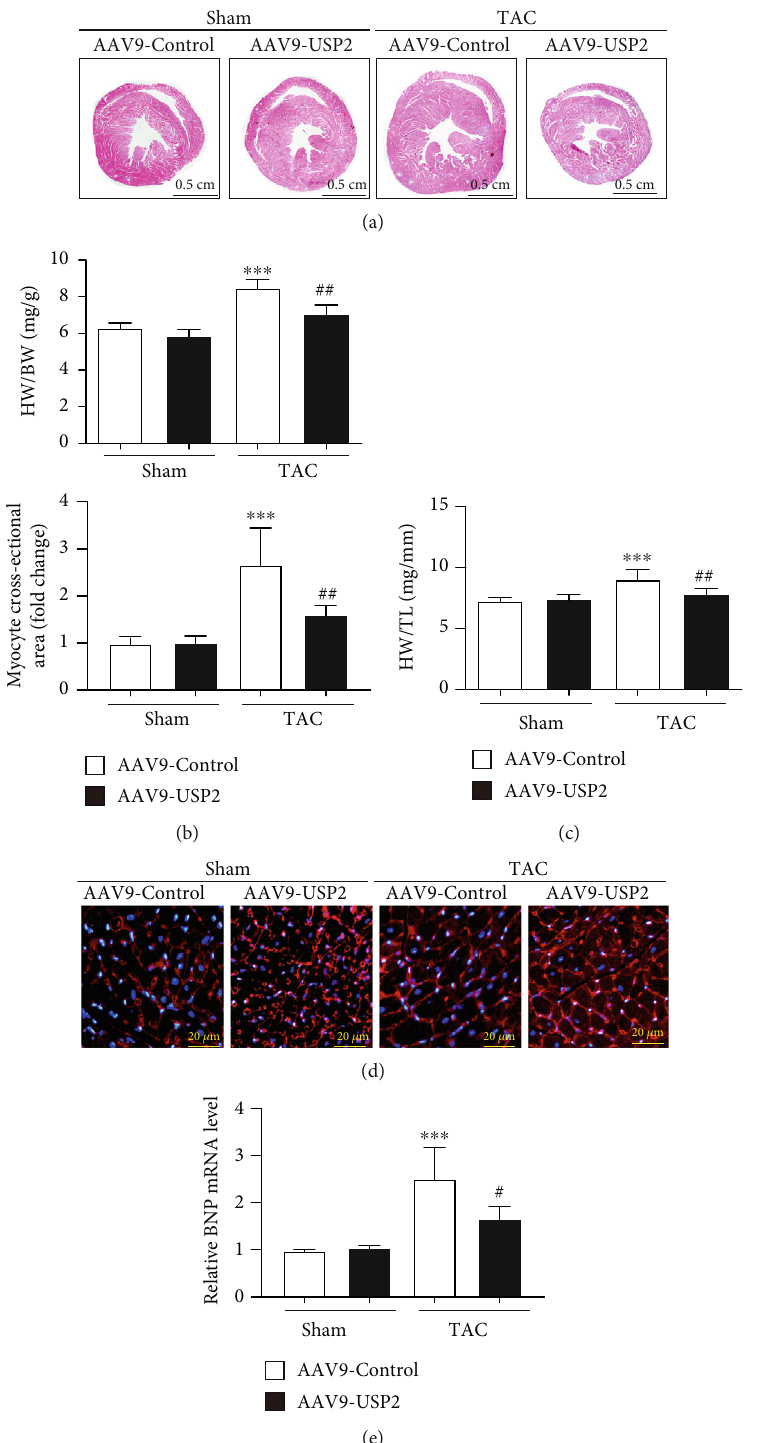
Figure 3: Overexpression of USP2 suppressed cardiac hypertrophy induced by pressure overload. (a) Histological analysis of heart sections from AAV9-Control or AAV9-USP2-treated mice following sham or TAC. (b and c) Heart weight to tibia length ratios (HW/TL) and body weight ratios (HW/BW) from AAV9-Control or AAV9-USP2-treated mice following sham or TAC. (d) Heart cross-sections were stained with wheat germ agglutinin (WGA). (e) Brain natriuretic peptide (BNP) mRNA levels in the hearts of AAV9-Control or AAV9-USP2- treated mice following sham or TAC. All values are presented as the relative value of the sham (AAV9-Control) value. ∗ P < 0 : 05 and ∗∗ P < 0 : 01 (AAV9-Control plus TAC vs. AAV9-Control plus sham); # P < 0 : 05 and ## P < 0 : 01 (AAV9-Control plus TAC vs . AAV9-USP2 plus TAC). n = 6